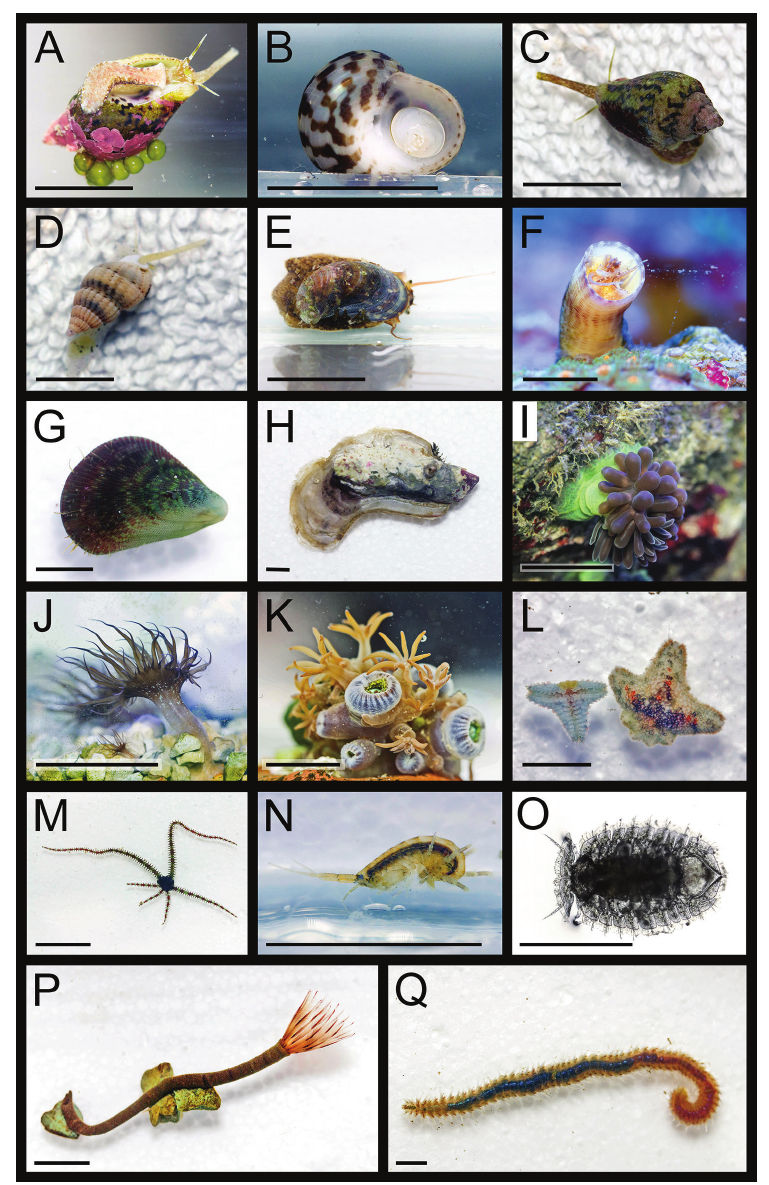
Figure 1. Found marine invertebrates A dove snail Amphissa / Columbella sp. with shell partly encrusted by algae B gastropod Collonista sp. C unidentified gastropod D unidentified gastropod e top-snail Sto- matella sp. F worm snail Serpulorbis / Thylacodes sp. G unidentified bivalve h bivalve Isognomon legumen i unidentified sea anemone, possibly Anemonia cf. manjano J unidentified glass anemone, possibly Aiptasia sp. K soft coral Acrossota amboinensis l unidentified starfish, possibly Asterina sp. (left: typical three-armed regrown individual, right: individual with regenerated arms) M brittle star Ophiocomella sp. with four regenerated arms N amphipod Niphargus sp. O isopod Cymodoce sp. P fanworm Bispira sp. Q fireworm Eurythoe sp. Scale bars: 5 mm ( A–N , P–Q ), 1 mm ( O